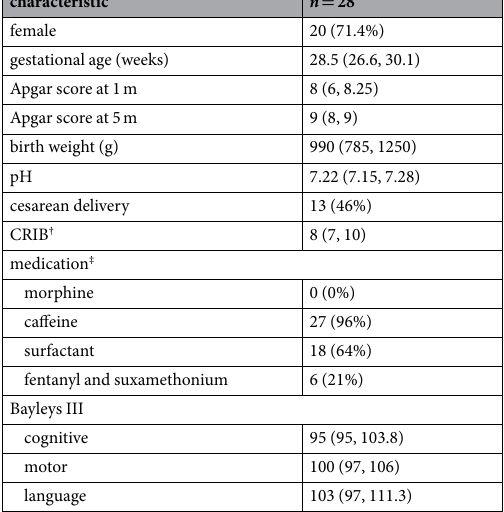
Table 1. Patient characteristics presented as either median (inter-quartile range) or sample size (%). † Clinical